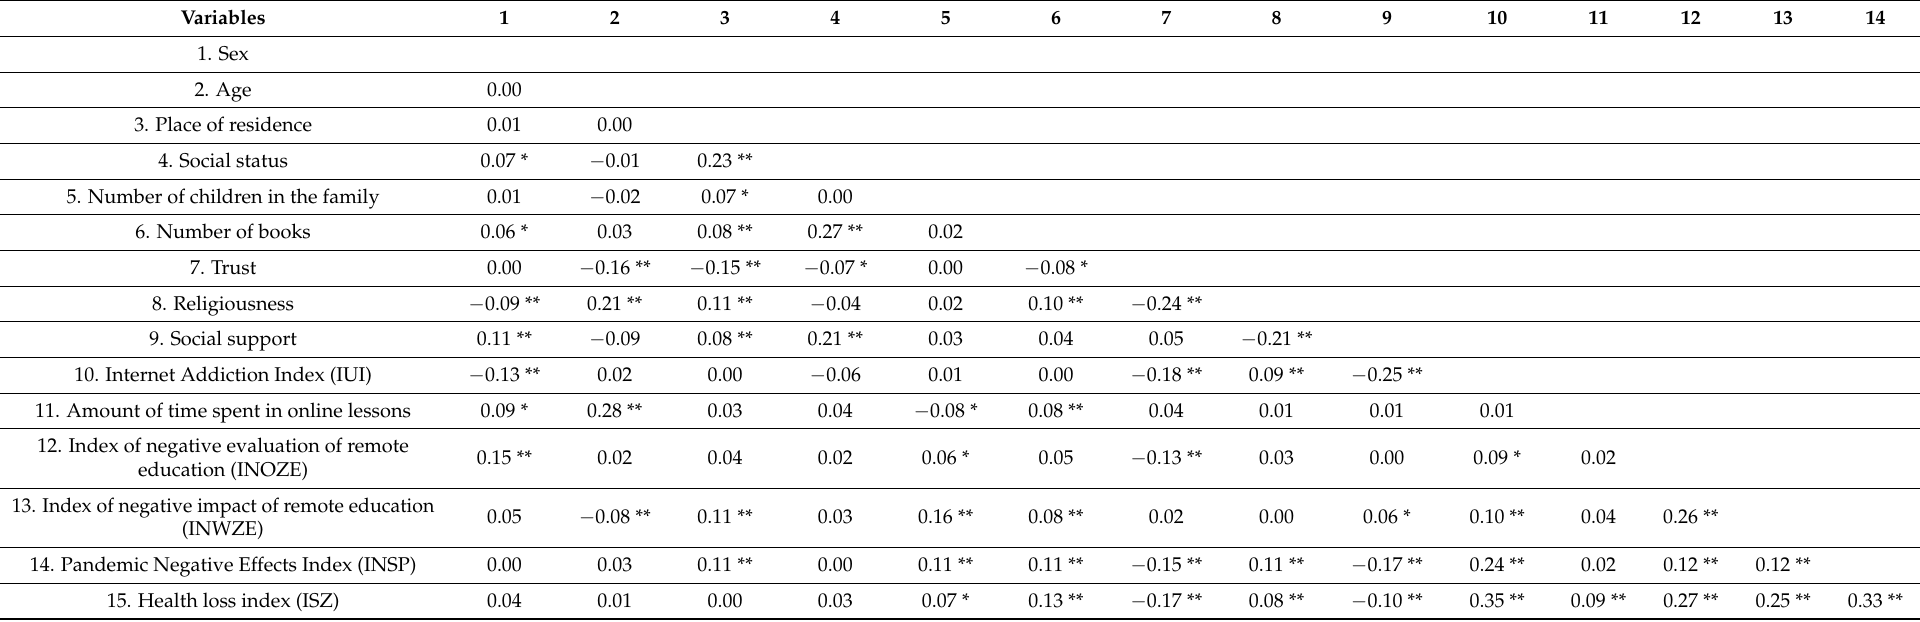
Table 4. Correlation coefficients among all